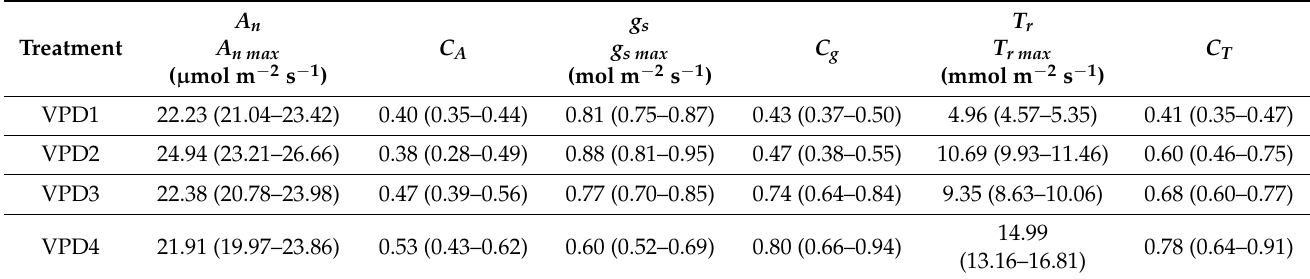
Table 1. Results of the linear-plateau regression of leaf net photosynthesis rate ( A n ), stomatal conductance ( g s ) and transpiration rate ( T r ) to the reduction in fraction of transpirable soil water ( FTSW ) for the potato plants grown in the greenhouse cells. Data are shown in Figure